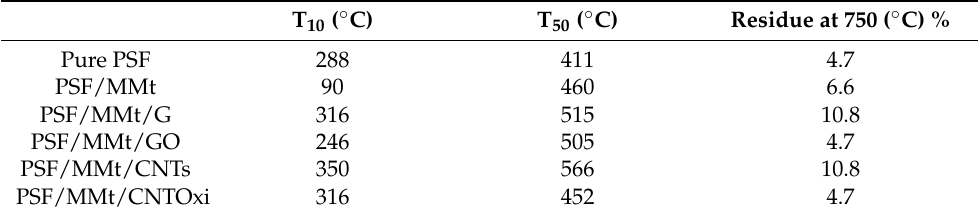
Figure 4. TGA curves of pure PSF, PSF/MMt, PSF/MMt/G, PSF/MMt/GO, PSF/MMt/CNTs, and PSF/MMt/CNTOxi. Table 2. Thermogravimetric data for the investigated samples.